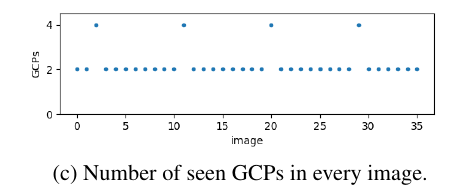
Figure 5. Results of visual localization with regularly spaced tie points and dynamic